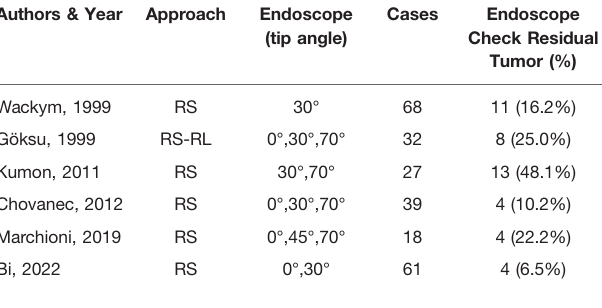
TABLE 3 | Endoscope check the residual